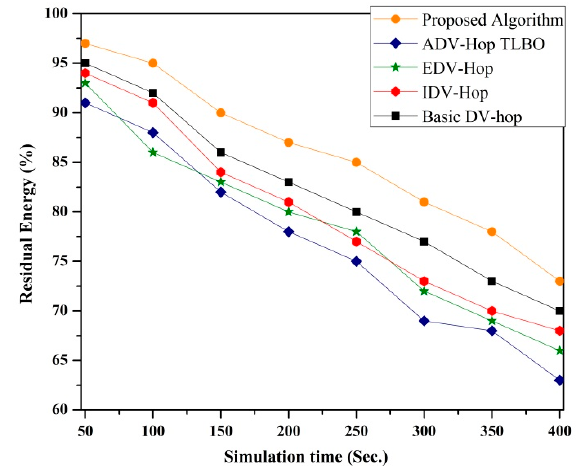
Figure 12. Impact of simulation time on residual energy. Table 6. Comparison of different performance evaluations.